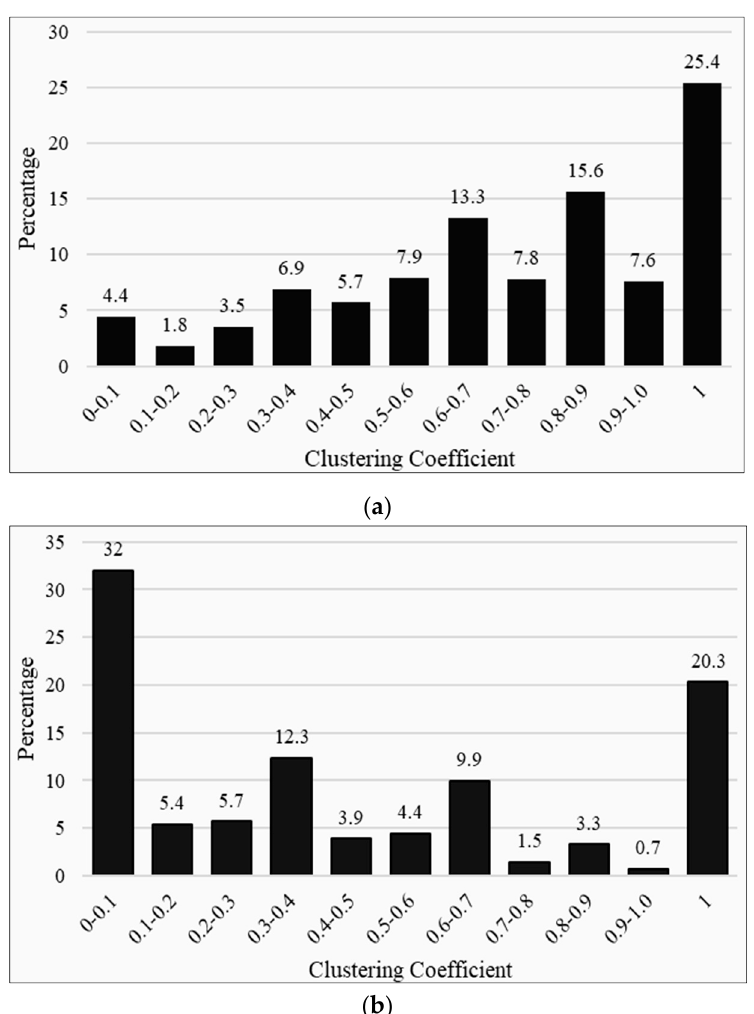
Figure 8. Percentage distribution of clustering coefficients of the geographic railway network. ( a ) Clustering coefficients of the high-speed railway network. ( b ) Clustering coefficients of the normal-speed railway network.